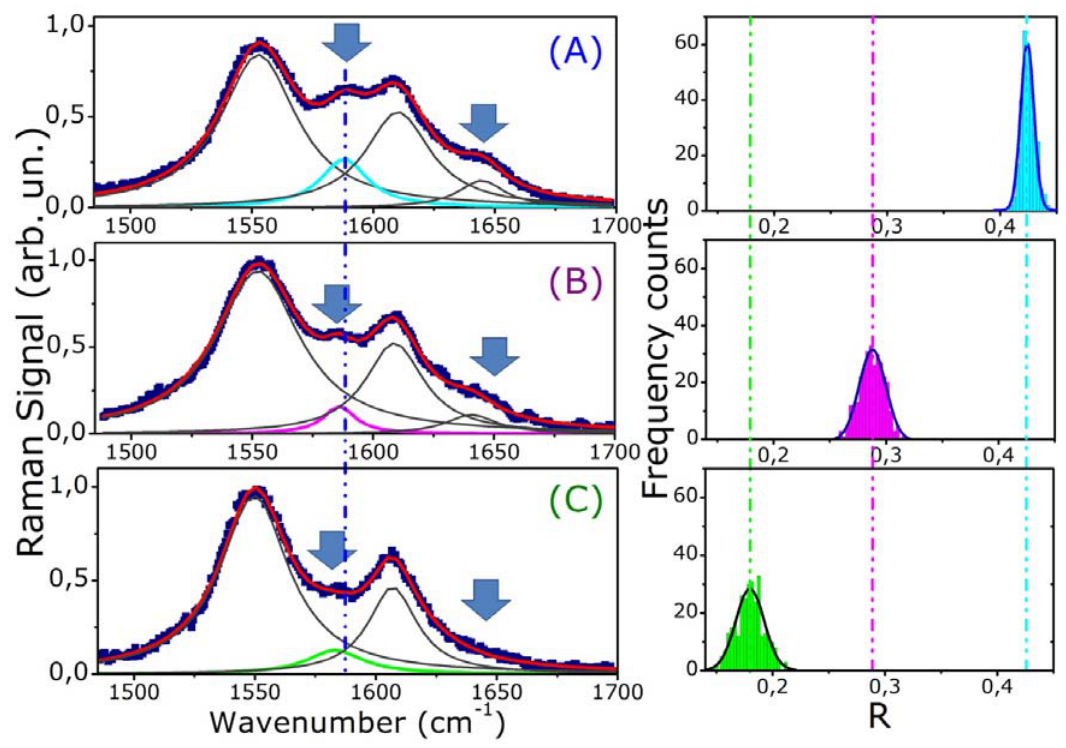
Figure 6. Comparison between the Raman spectra and (right) statistical distributions of the to  of (A) healthy, (B)  thalassemic, and (C) ratio R of the Raman peaks     thalassemic RBC. The arrows in the left part of the Figure indicate spectral features whose intensity changes significantly and the dash-dotted line highlights the observed wavenumber shift of the spectral